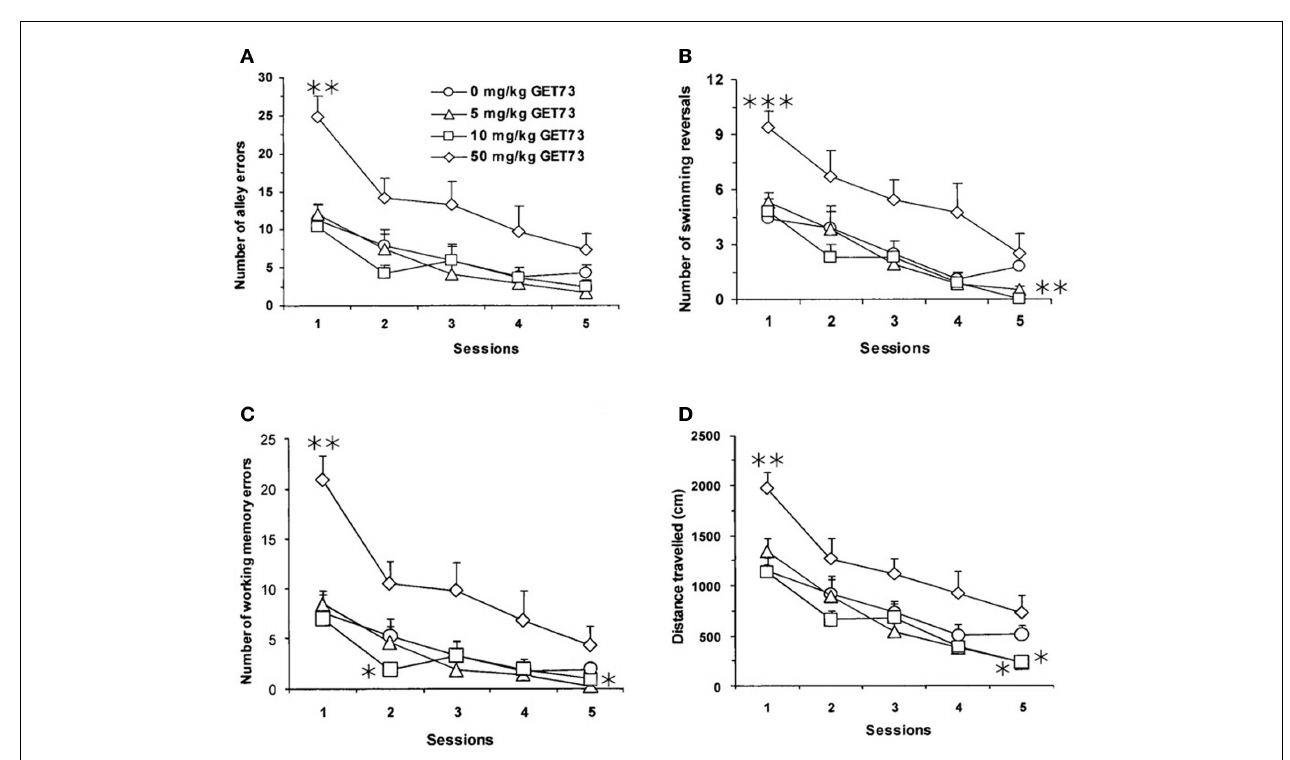
the on-going session (C)], and distance traveled [in cm; (D)]. GET73 was administered 30min before eachWM session. EachWM session lasted for 5min. Each point is the mean ± SEM of n = 10. * P < 0.05, ** P < 0.01, and *** P < 0.001 with respect to 0-mg/kg GET73-treated rat group in the corresponding session (Kruskal–Wallis and Mann–Whitney test).